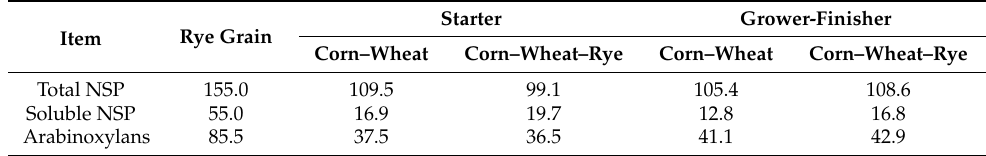
Table 2. Non-starch polysaccharide (NSP) content of rye grain and experimental diets (g/kg DM) 1 .